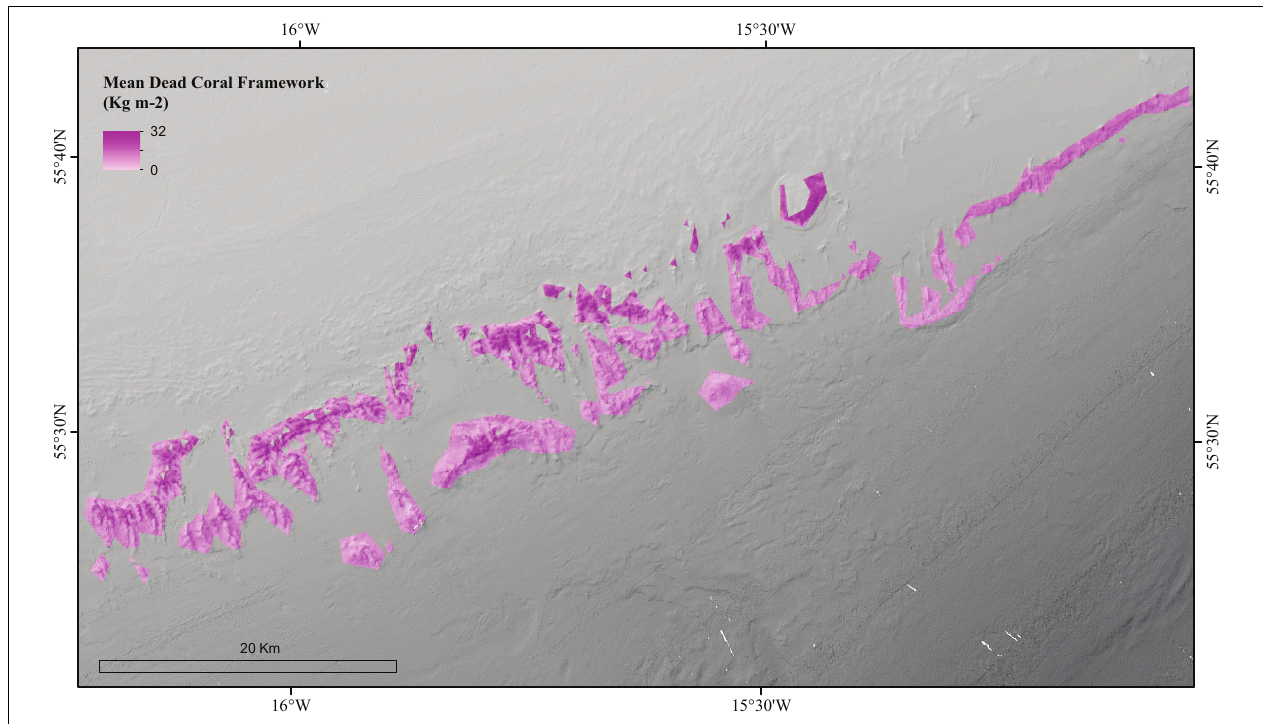
FIGURE 7 | Modeled amount of the mean biomass of dead coral framework in the coral habitat suitability model area of the Logachev Mound Province.